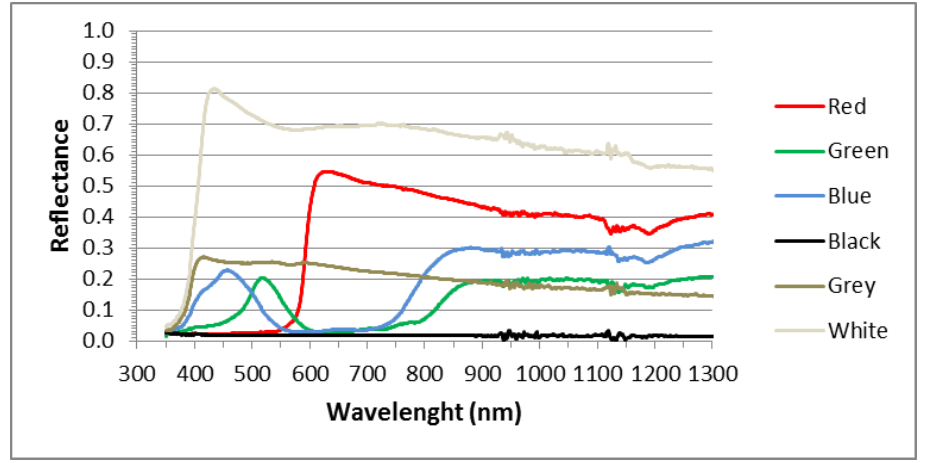
Figure 10. The spectral signature of the control surfaces (vinyl sheets) used in the radiometric calibration